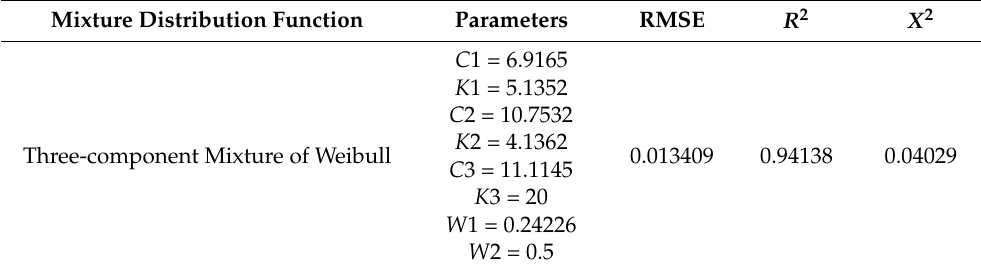
Table 6. Probability distribution parameters for the three-component mixtures of PDFs in the solar irradiance